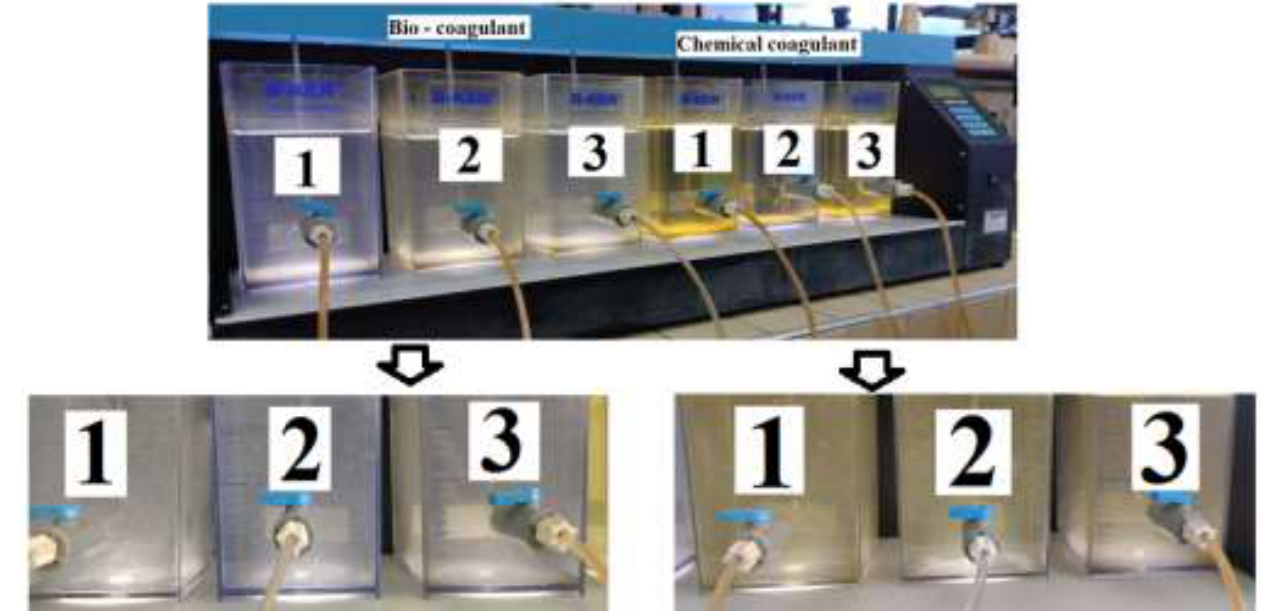
Figure 1. Experimental setup used for the coagulation process using OFI peel mucilage ( left ) and FeCl 3 ( right ). Labels 1 to 3 refer to the measurements made in triplicate in each case. Synthetic turbid water samples treated with biocoagulant (OFI fruit peel mucilage) and chemical coagulant (FeCl 3 ) were analyzed according to the Standard Methods for